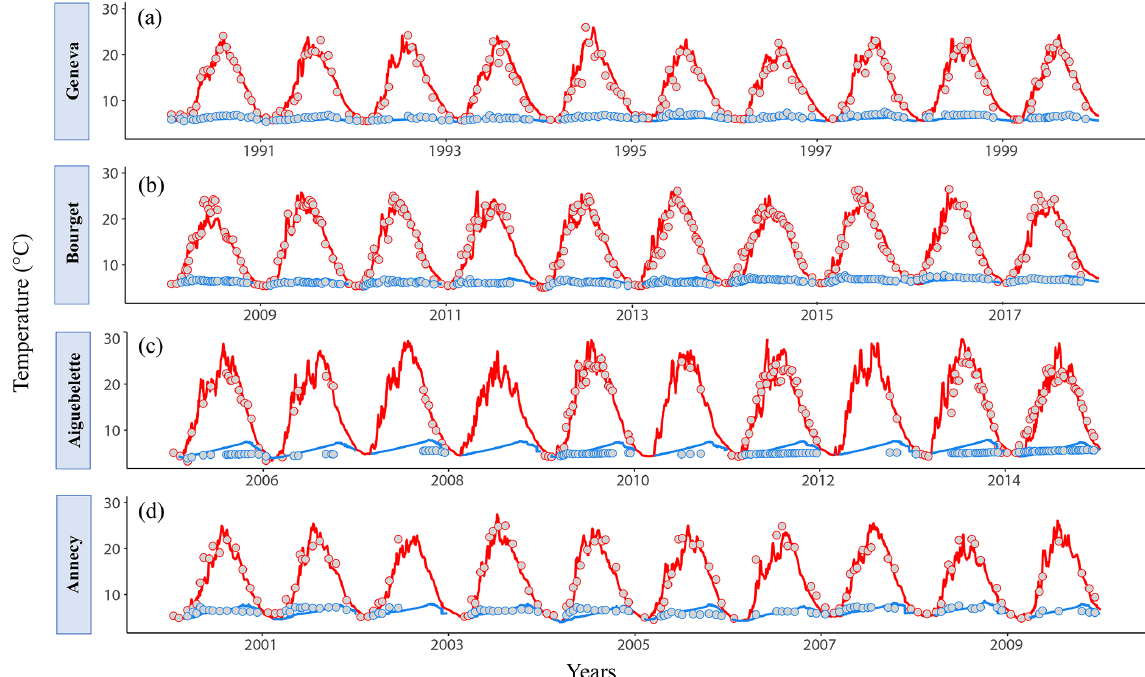
Figure 2. Temporal variations in epilimnion (red) and hypolimnion (blue) temperatures of Lake Geneva (a) , Bourget (b) , Aiguebelette (c) and Annecy (d) . MyLake simulations (line) vs. observations (point) over the 10-year validation period.